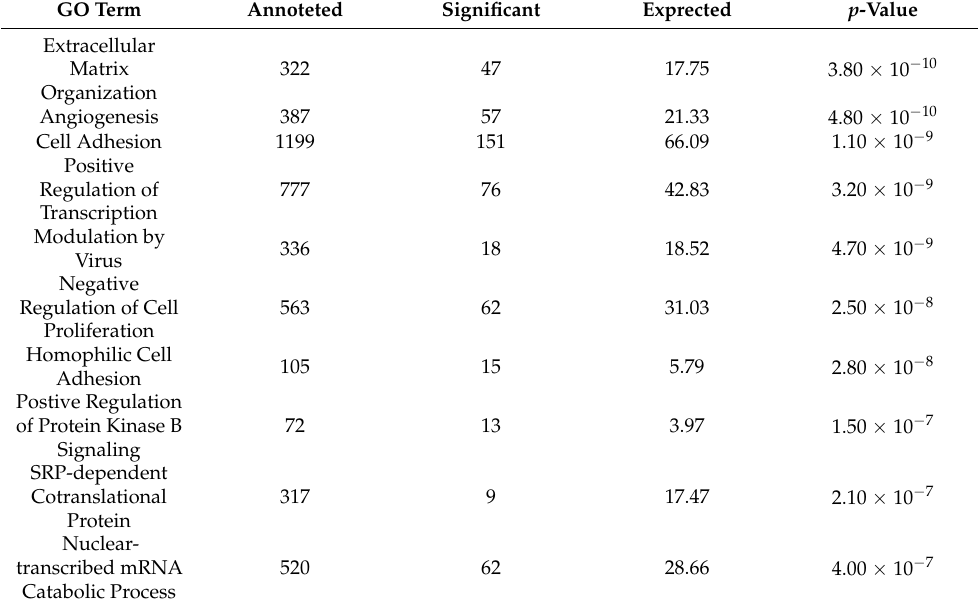
Table 4. Top 10 most significant GO terms associated with transcripts found to be differentially expressed between ASCs and